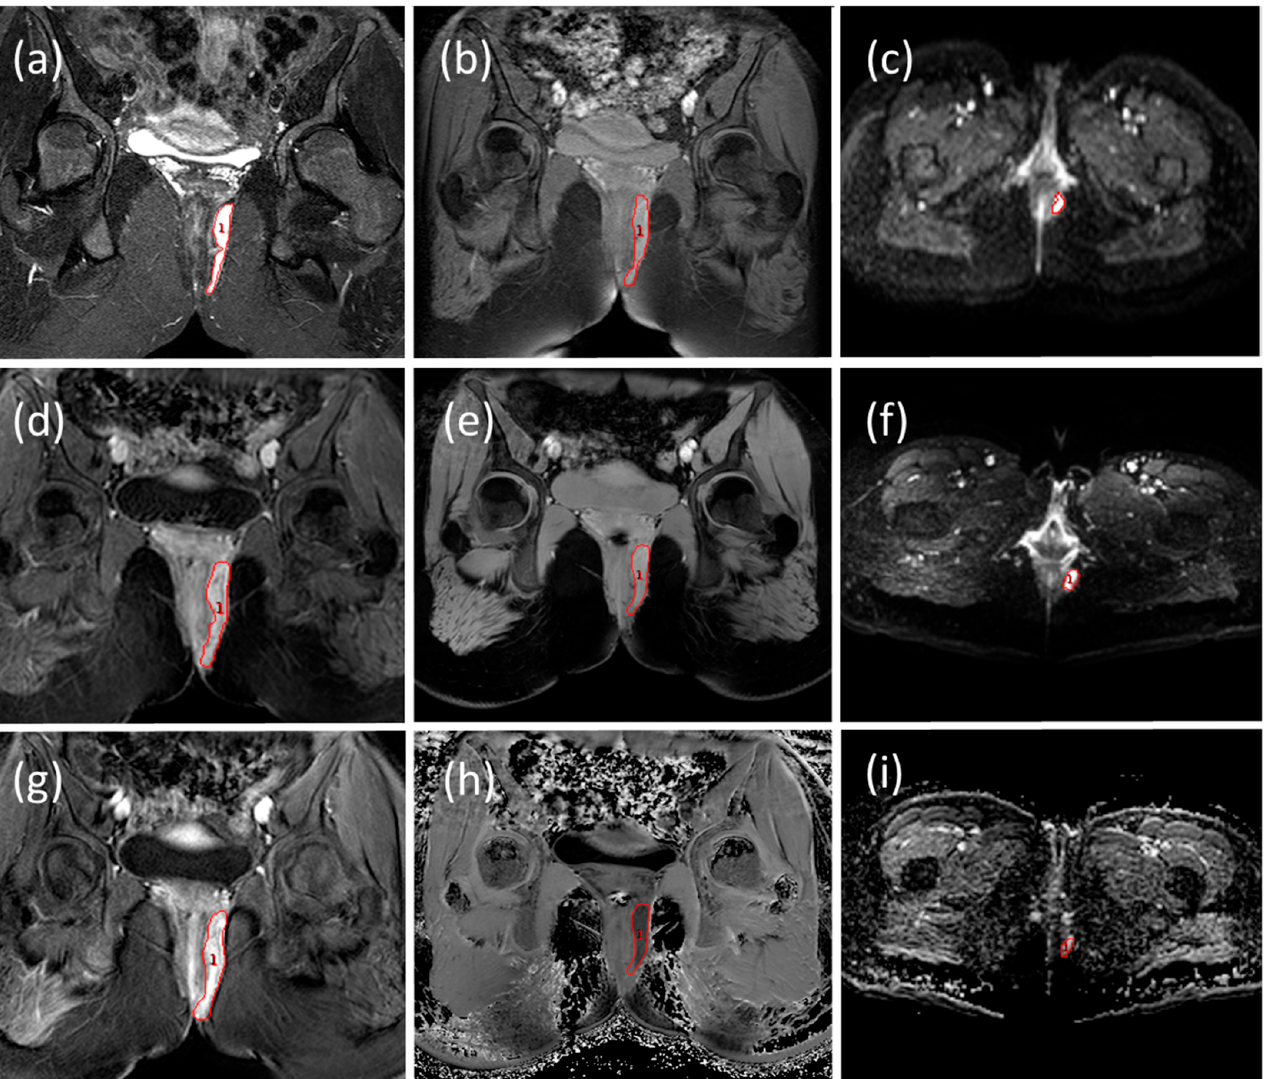
Figure 2. Patient with clearly visible fistula. ( a ) 1.5 T coronal STIR image where a radiologist drew the ROI and ( b ) 1.5 T MT ‘on’ image. ( c ) 1.5 T DWI b0 image shows where the ROI were copied. ( d ) 3.0 T coronal T1 post-contrast image where a radiologist drew the ROI and ( e ) 3.0 T MT ‘on’ image. ( f ) 3.0 T DWI b0 image where the ROI was copied. ( g ) 3.0T DCE image ( h ) 3.0 T MTR MAP and ( i ) 3.0 T ADC MAP with ROI shown from where results were calculated.